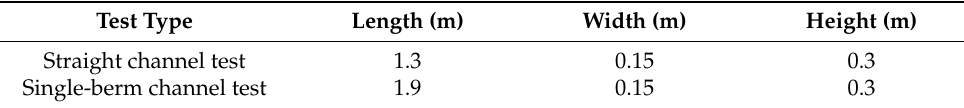
Table 2. Dimensions of the channels for each test type.